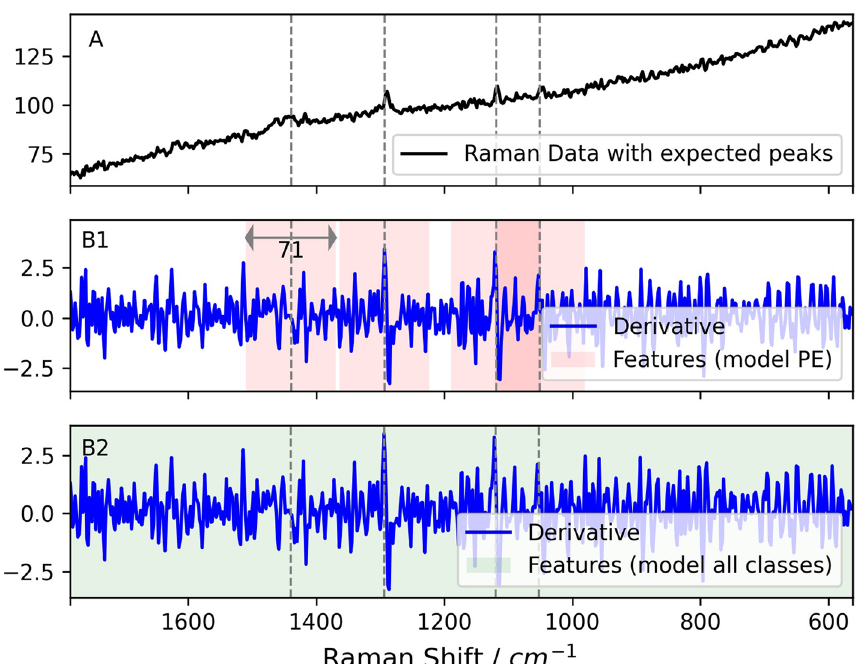
Fig. 4 For one single model, the gradient of the Raman shift (562—1784 cm − 1 ) was included (B2). For one model per class (PE in this case) sections around the peaks were extracted (B2)